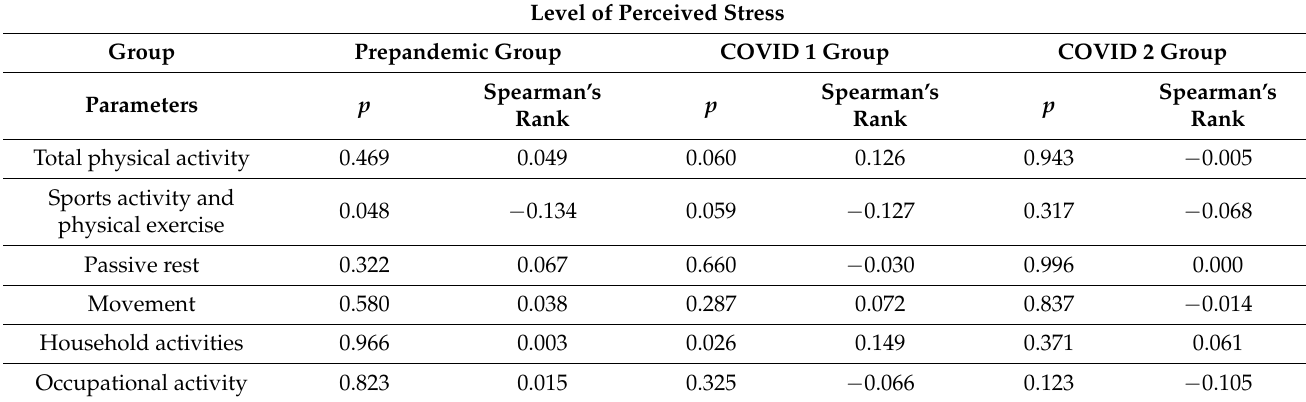
Table 7. Spearman’s Rank Correlations—Physical Activity and